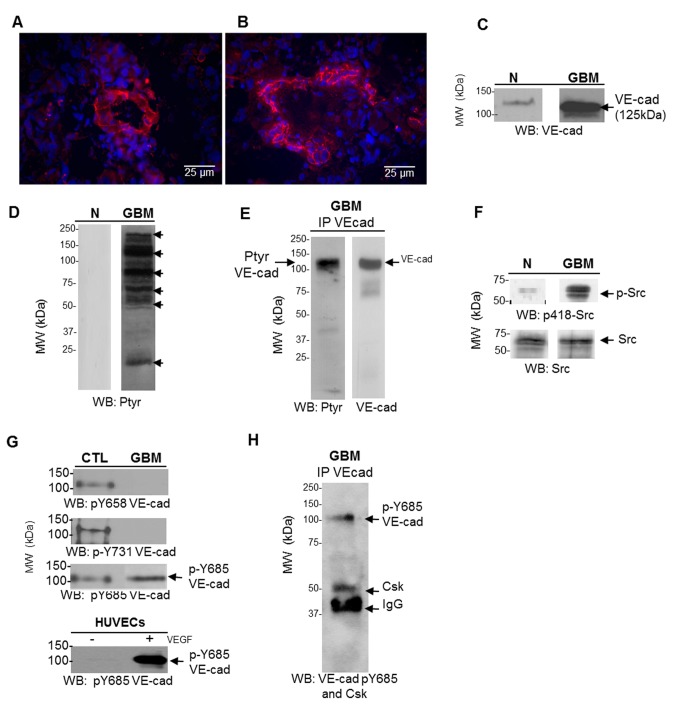
VE-cadherin expression and phosphorylation in human glioma tissues.(A,B) Representative (n=10 samples) micrographs of primary human glioma stained for VE-cadherin (in red; nuclei are stained in blue). Images were processed using Adobe Photoshop Scale bar: 25 μm. A capillary network positive for VE-cadherin was detected in all the tumors. (C) A 125 kDa fragment of VE-cadherin was highly detectable in glioblastoma (GBM) extract and not in non-tumor brain tissue (N). (D) Protein lysates from N and GBM were analyzed by SDS-PAGE and western blotting with the antiphophotyrosine antibody (clone 4G10). Several proteins with apparent molecular masses (indicated by filled arrowheads) ranging from 220 to 25 kDa displayed clearly strong tyrosine phosphorylation in GBM but not in non-tumor tissue. (E) 500 μg of GBM tissue lysate protein were immunoprecipitated with an anti-human VE-Cadherin antibody directed to C-term of the protein and blotted with the indicated antibodies (Ptyr or VE-cad). Immunoprecipitation of VE-cadherin from glioma extracts allowed to detect a tyrosine phosphorylated form of VE-cadherin. Sample loading was controlled using actin detection. (F) Active Src (phosphoY418) was highly detectable in GBM but not in non-tumor (N) brain extract. (G) Orthovanadate treated-HUVECs lysates (control: CTL) and GBM extracts (50 µg) were analyzed by western blot using antiphosphosite antibodies directed against Y658 and Y731, and the antibody directed against pY685 VE-cadherin raised in our laboratories. Only pY685 was detected in GBM as in HUVECs upon VEGF stimulation (50 ng/mL). (H) Same experiment as described in (E), and immunoblotting with anti-Csk antibody and anti-pY685 VE-cadherin antibody. The association of Csk with VE-cadherin in GBM confirmed the phosphorylation at the site Y685 also detected with the antiphosphosite antibody. Filled arrowhead indicates the position of the IgG heavy chains of the crosslinking antibody. In all blots the position of size markers (in kDa) is indicated on the left. These experiments were repeated at least three times in a similar configuration.